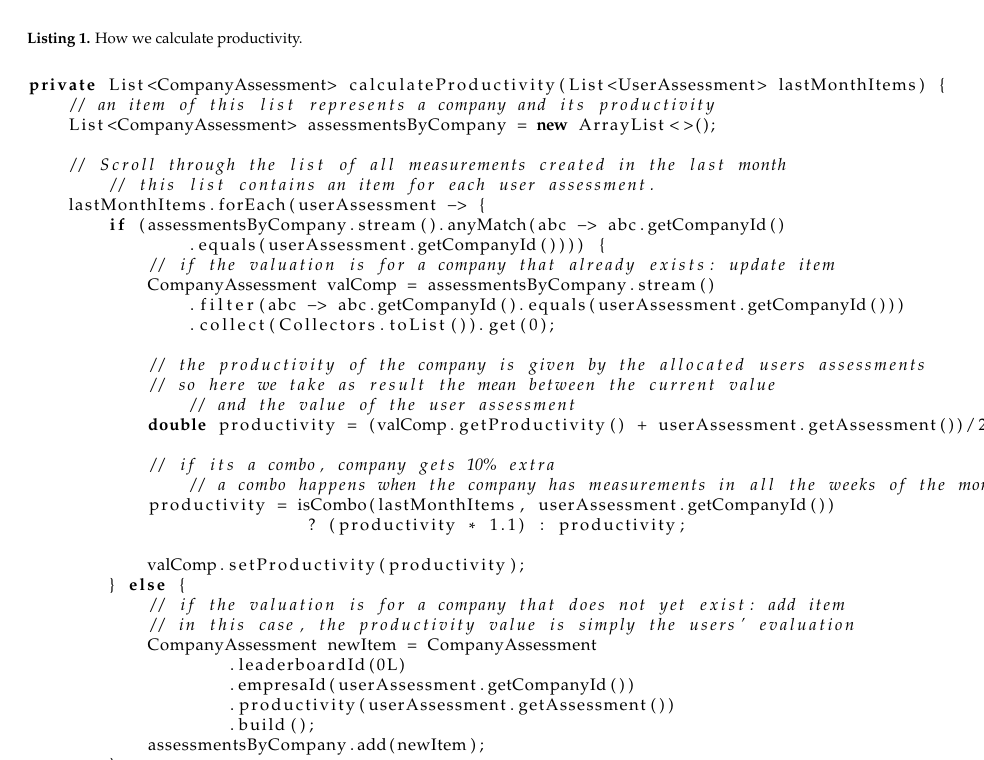
Figure 10. Productivity